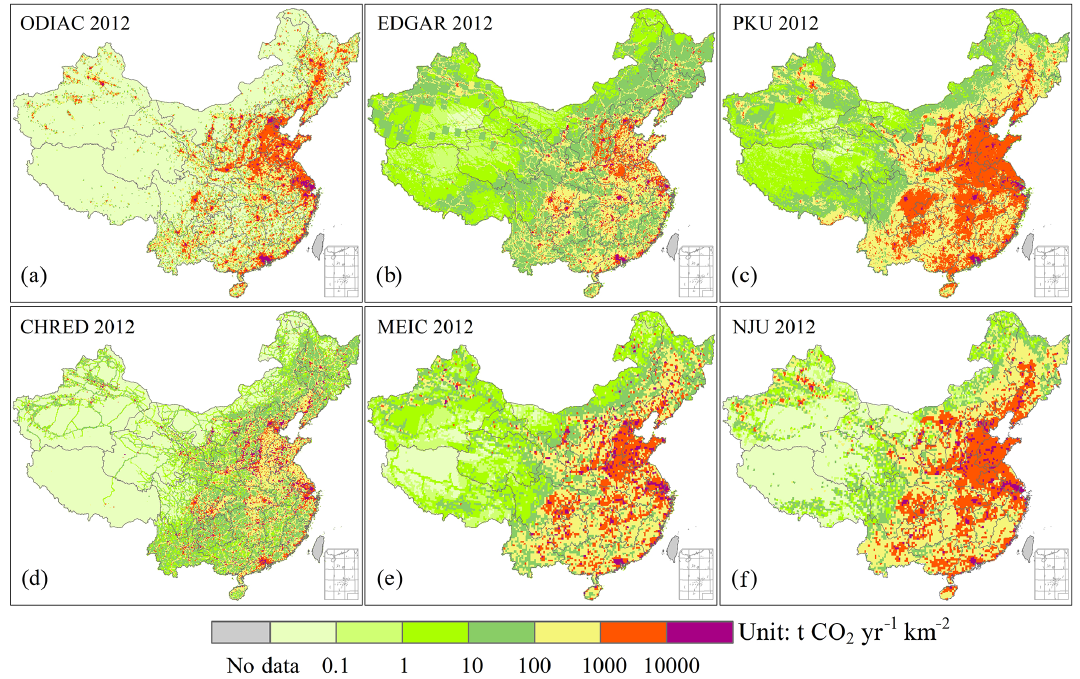
Figure 3. Spatial distributions of ODIAC (a) , EDGAR (b) , PKU (c) , CHRED (d) , MEIC (e) , and NJU (f) at a 10km resolution for 2012. ODIAC was aggregated from 1km data, such that MEIC, PKU, and EDGAR were resampled from 0.25, 0.1, and 0.1 ◦ .